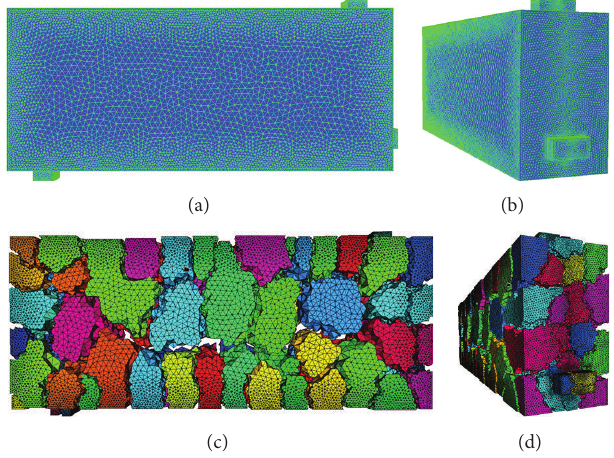
Figure 2: Mesh and domain